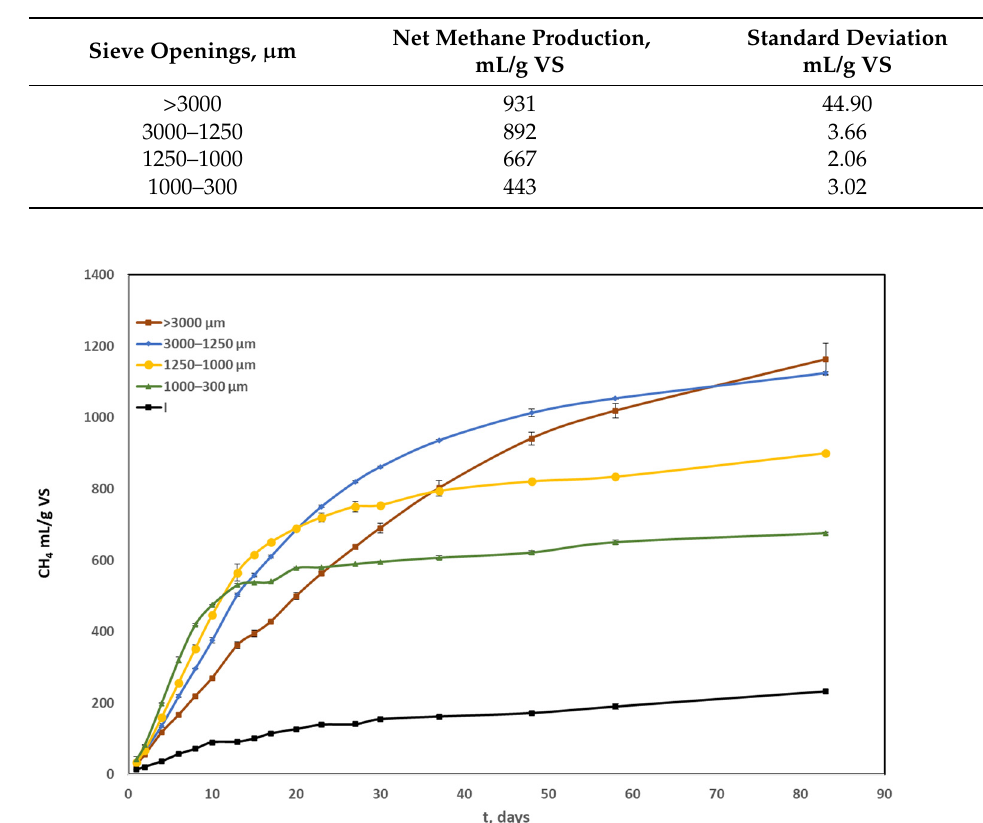
Figure 2. Biochemical methane production potential for fine screenings collected from sieves with openings of various sizes, and for the anaerobic sludge sample used for inoculation.